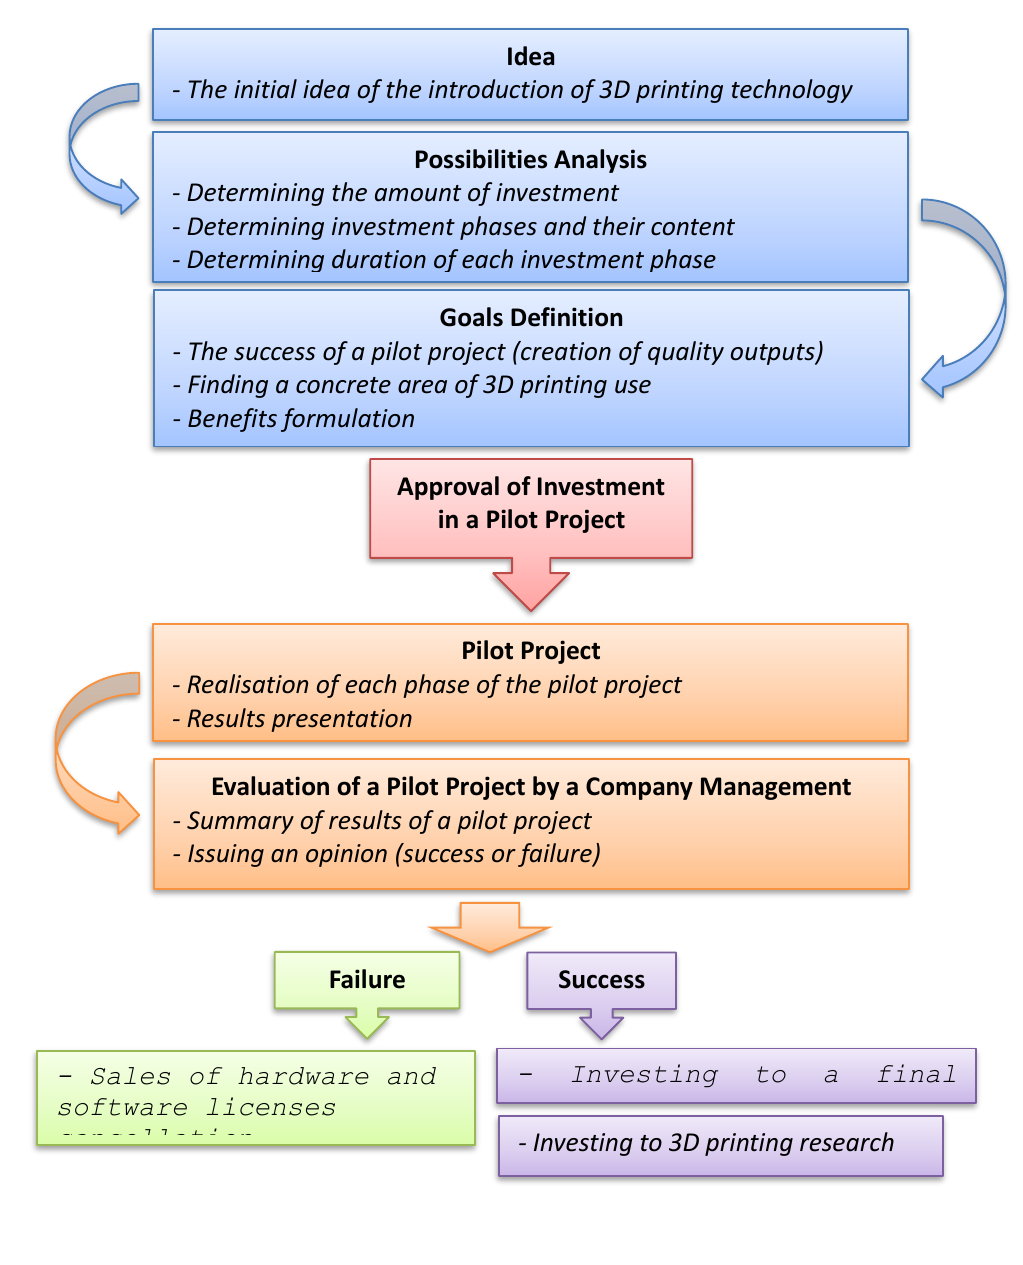
Figure 1: Example of the Pilot Project Lifecycle Introducing 3D Printing (source: